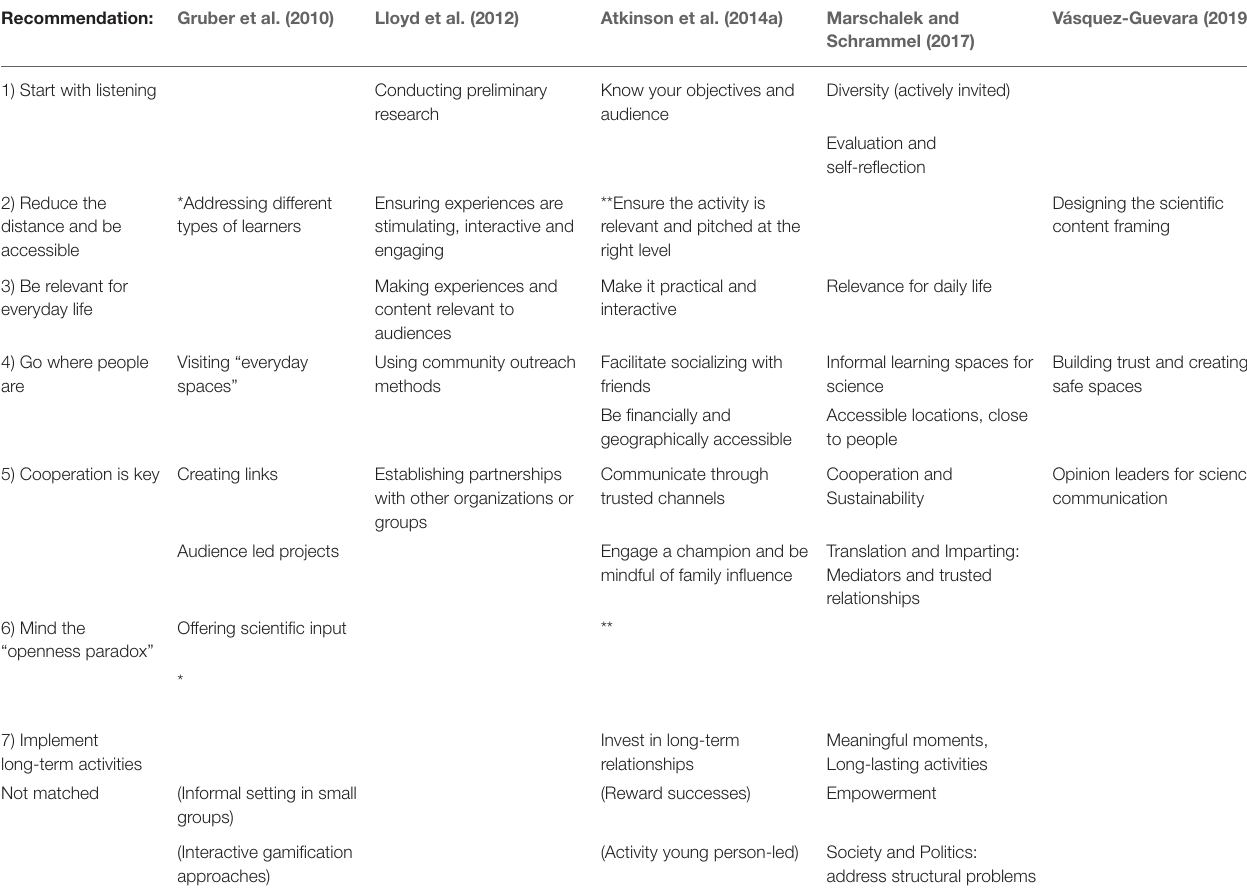
TABLE 1 | Comparison of the recommendations put forward in this paper and those identified in the review. Recommendation: Gruber et al.